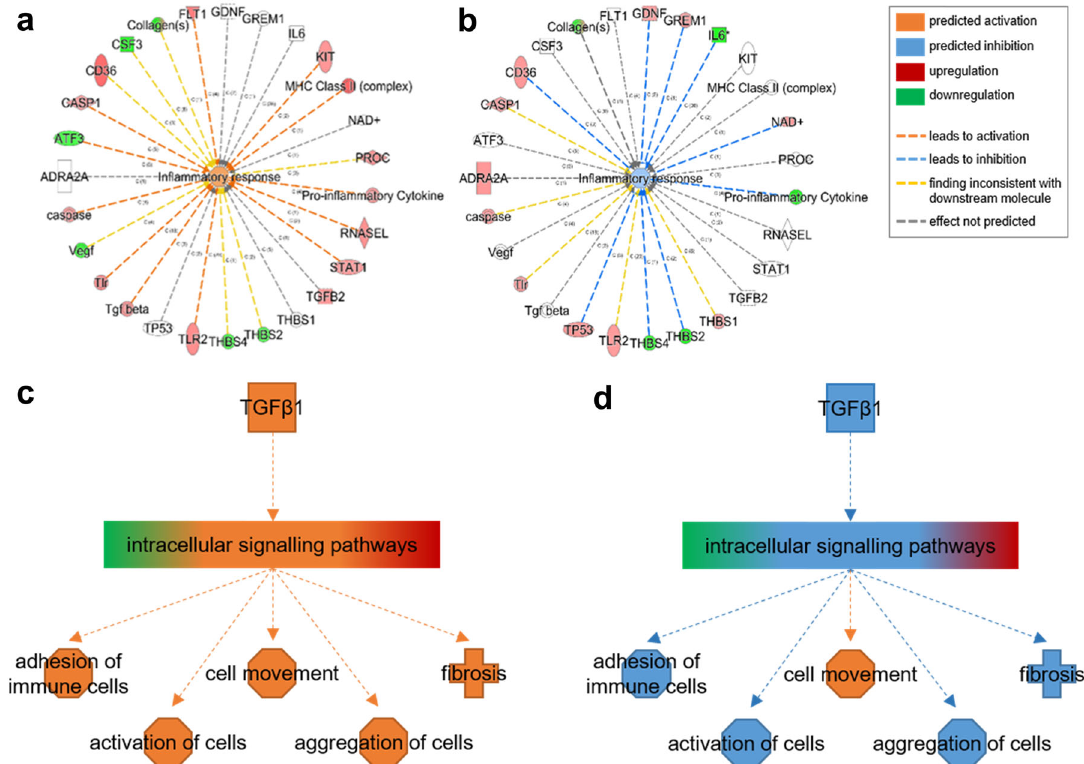
Fig. 2 ILB ® modulation of in fl ammation and TGF β 1 pathways. Summary of the TGF β signalling genes that were differentially regulated in human Schwann cell cultures over 48 h in the absence ( a , c ) and presence of ILB ® ( b , d ) ( n = 3). When placed in culture the Schwann cells exhibit a pro-in fl ammatory phenotype, i.e. responding to endogenous pro-in fl ammatory cytokines, including TGF β , that initiate a cascade of in fl ammatory responses ( a , b ). Red denotes the genes upregulated in the Agilent gene array data set, green indicates the genes downregulated in the Agilent array data set. TGF β signalling (a pro-in fl ammatory cytokine) regulates the expression of a large number of molecules that control numerous cellular responses. The known downstream molecular interactions of TGF β signalling molecules (derived from the IPA knowledge base) allow the prediction of the downstream cellular effects of TGF β modulation ( c , d ). The orange in fl ammatory designation indicates the activation of an in fl ammatory cellular response to the pro-in fl ammatory gene expression pro fi le seen under normal culture conditions ( c ); the blue anti-in fl ammatory designation shows the resolution of in fl ammation seen after inhibition of the expression of pro-in fl ammatory genes by ILB ® ( d ). In the human Schwann cell cultures ( c ), TGF β activation elicits the activation of immune cells and fi brosis and while ILB ® treatment ( d ) inhibits these changes, with the exception of cell